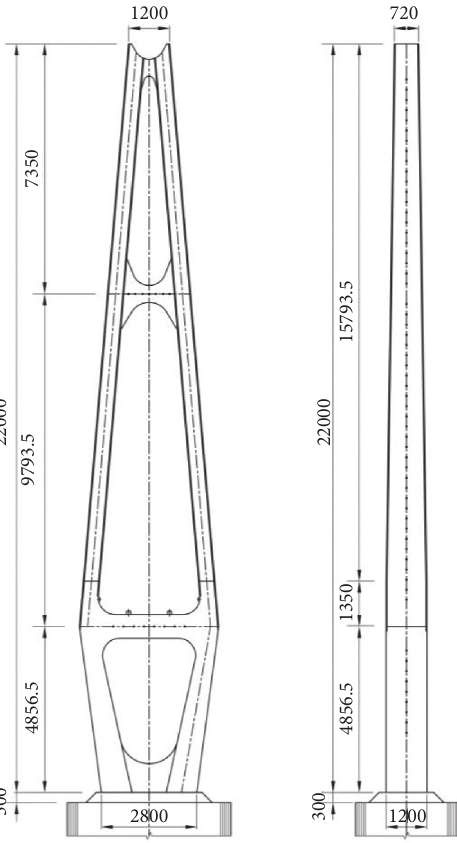
Figure 3: The structural layout of the main tower (unit: m).